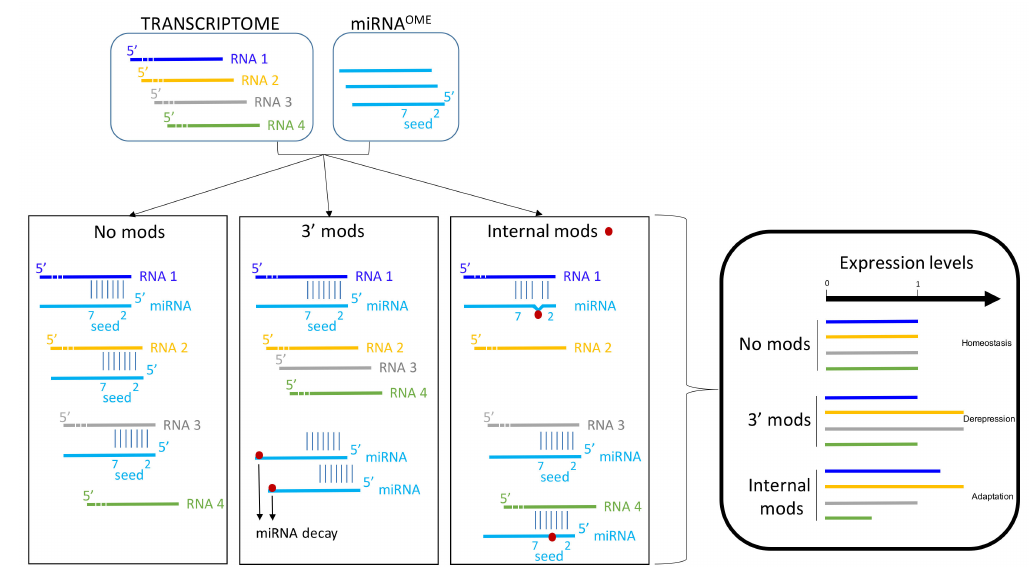
Figure 3. Epigenetic modifications and functional outcomes for miRNA and sRNA. Several epigenetic modifications might affect miRNA and sRNA functions. The majority of these RNAs are not modified. 3 (cid:48) mods may promote miRNA decay. Internal mods, especially in the seed region of miRNA, may modify the pairing between miRNA and its targets (RNAs). In basal condition (homeostasis), a miRNA (here in blue) can bind to RNA 1–3. RNA 4 is not targeted by this miRNA. Expression levels of these four RNAs is arbitrarily estimated to 1 in basal condition. The decrease of miRNA amount per